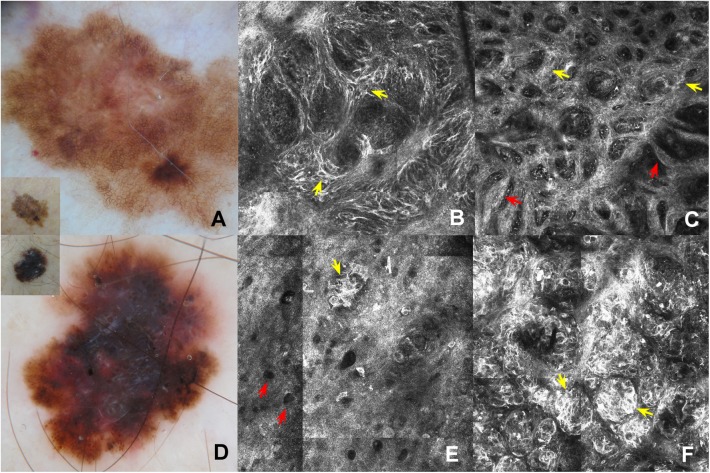
Comparison between findings of dermatoscopy and RCM.(A) Dermoscopy of BRAF V600E negative in situ superficial spreading melanoma: broadened pigmented network (the inset corresponds to clinical image). (B) RCM mosaic image (1.5x1.5 mm) in DEJ shows junctional thickening due to isolated atypical cells (yellow arrows). (C) RCM mosaic image (1.5x1.5 mm) in DEJ showing non-edged papillae separated by loosely thick interpapillary spaces (yellow arrows) and meshwork pattern (red arrows). (D) Dermoscopy of BRAF V600E mutated superficial spreading melanoma, 1 mm in Breslow thickness): multicomponent pattern (the inset corresponds to clinical image). (E) RCM mosaic image (0.75x0.75 mm) at the level of the epidermis shows hyporeflective pagetoid cells (red arrows) and epidermal nests (yellow arrow). (F) RCM mosaic image (0.75x0.75 mm) at the level of the DEJ shows dermal-epidermal nests (yellow arrows).